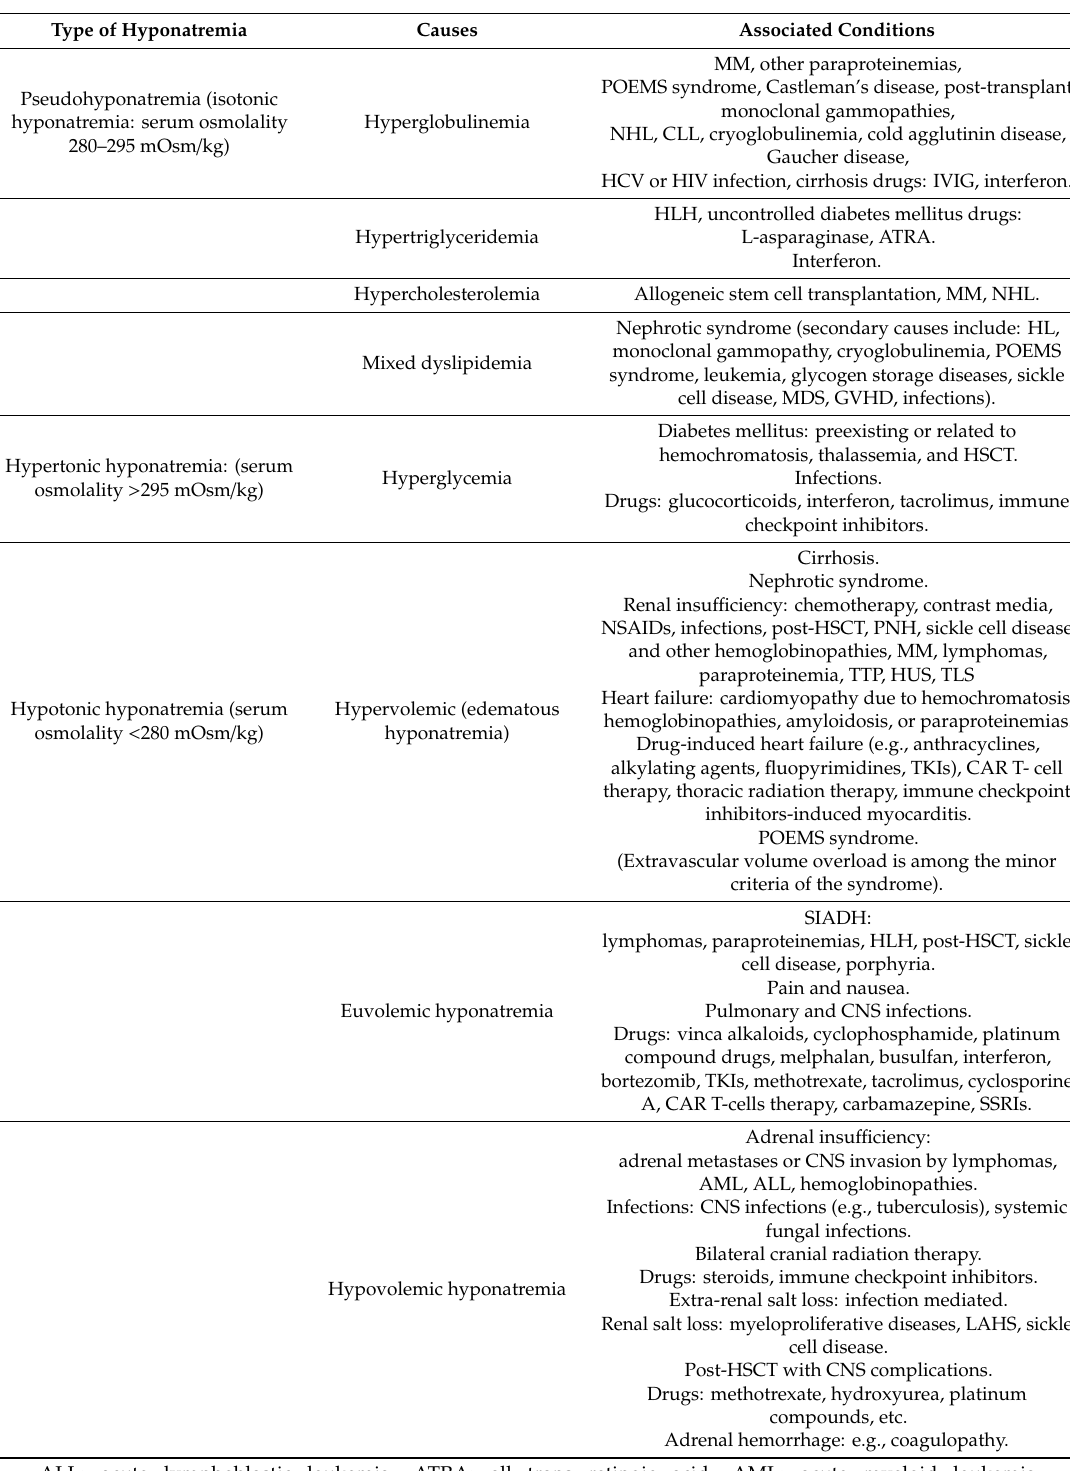
Table 1. Causes and / or superimposed factors of hyponatremia in hematological